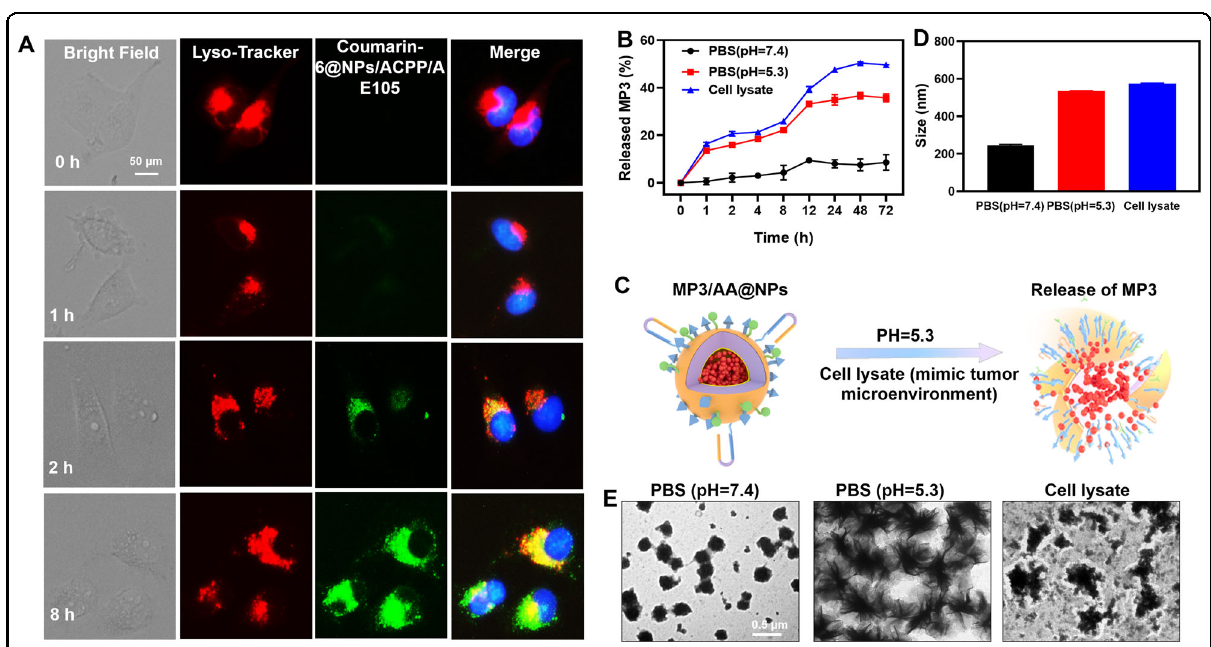
Fig. 2 Intracellular localization and drug release of MP3/AA@NPs. A The cellular traf fi cking of coumarin-6/AA@NPs in MDA-MB-231 cells at different time intervals. B The percentage of released MP3 with different buffer at different times. C The degradation diagram of MP3/AA@NPs in low pH and cell lysate. D The size and E TEM images of MP3/AA@NPs in different media. Scale bar: 500